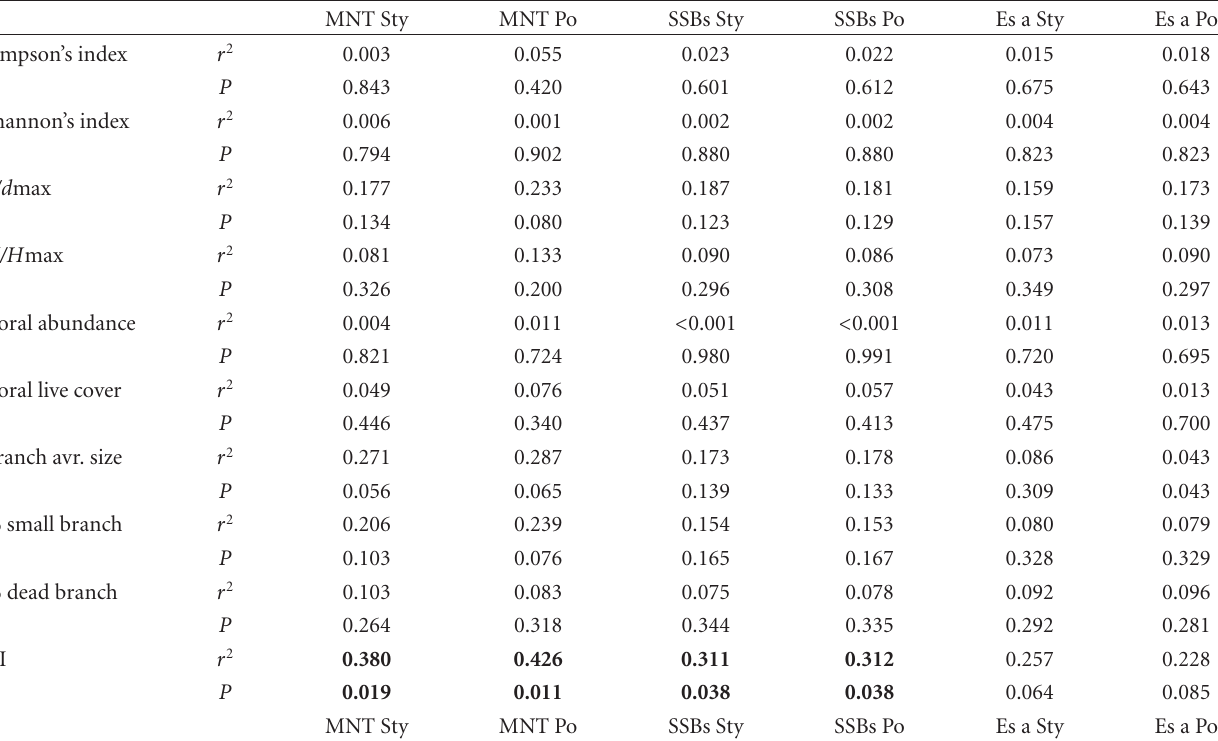
Table 5: Results of the regression between the ecological indices obtained from the young coral communities and the cytological test results of samples from these communities. Correlation tests were conducted between the average values of each of the indices and the cytological tests at each station. In each square, the top figure is r 2 and the bottom is the P value. Bold figures mark significant correlations ( P < 0 . 05). In the cytological tests, MNT: micronucleus test, SSBs: − log of single strand breakage value, Es a: esterase activity, Sty: Stylophora pistillata and Po: Pocillopora damicornis